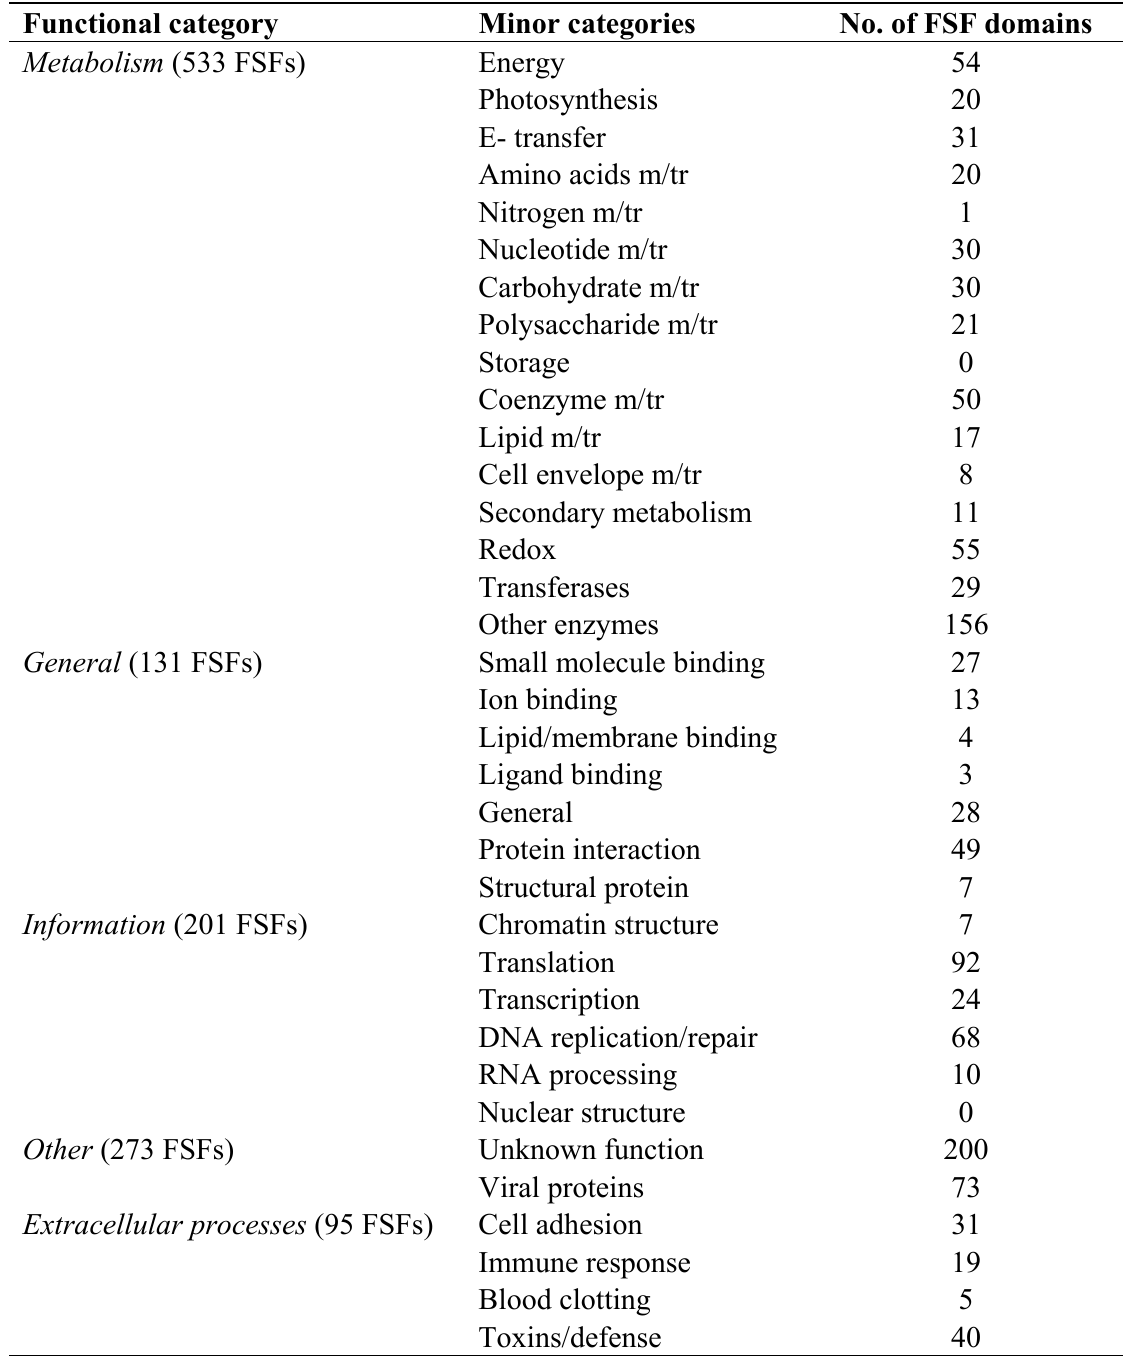
Table 1. Mapping between the general and minor functional categories for 1,781 protein domains defined in structural classification of proteins (SCOP) 1.73 and the number of fold superfamilies (FSFs) corresponding to each minor category in our dataset of 965 organisms. A total of 135 FSFs could not be annotated. m/tr, metabolism and